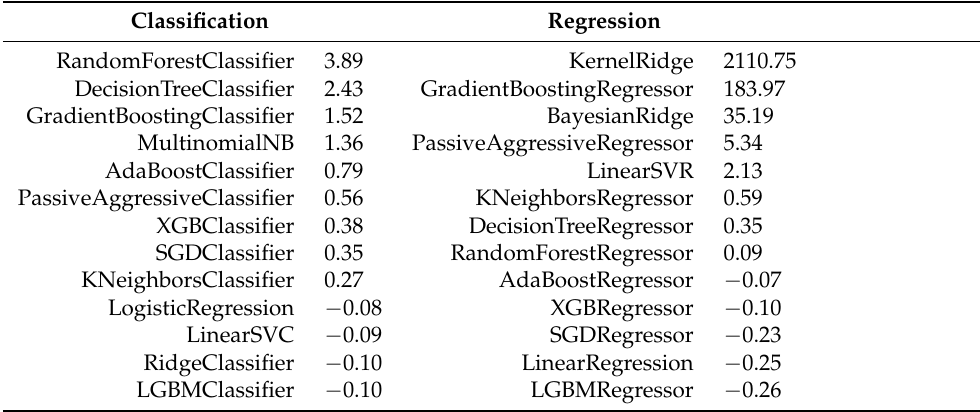
Table 3. The hp_score of each ML algorithm, computed from the values in Table 2. A higher value means that the algorithm is expected to gain more from hyperparameter tuning, while a lower value means that the algorithm is expected to gain less from hyperparameter